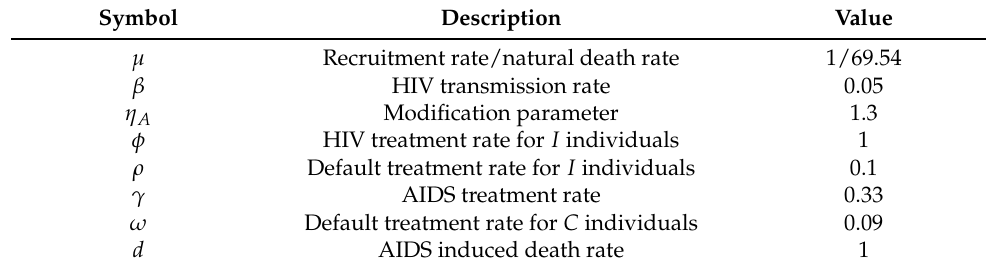
Table 1. Parameter values of model (9) corresponding to R 0 = 0.1863 < 1.